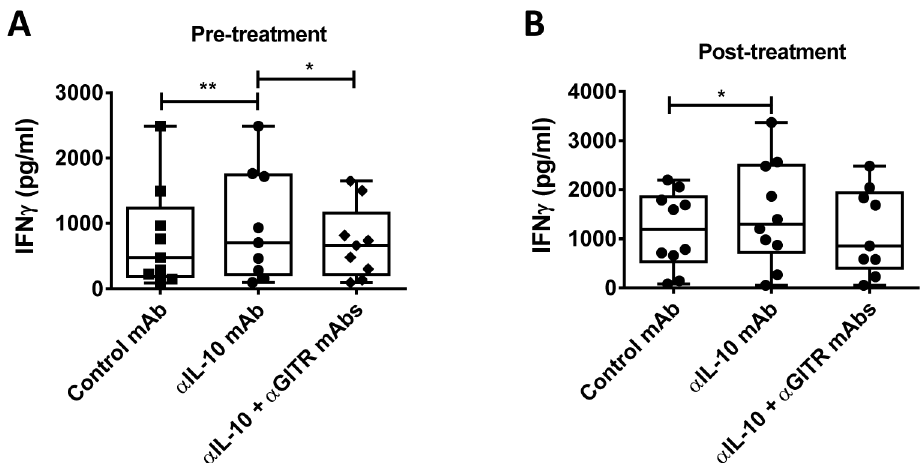
Fig 7. GITR activation alone or in combination with IL-10 blockade does not improve antigen-specific IFN γ production by whole blood cells after drug treatment. Antigen-specific IFN- γ production was measured on admission to clinic ( A ), and 24 hours after single-dose ambisome treatment ( B ), in whole blood cells cultured for 24 hours with a blocking anti-IL-10 mAb, with or without agonistic anti-GITR mAb, and compared with samples treated with control IgG1, as indicated (n = 10). Box and whisker plots show the box extending from the 25 th to 75 th percentiles with the line in the middle of the box representing the median and whiskers going down to the smallest value and up to the largest. Statistical differences of p < 0.05 ( * ) and p < 0.01 ( ** ) are